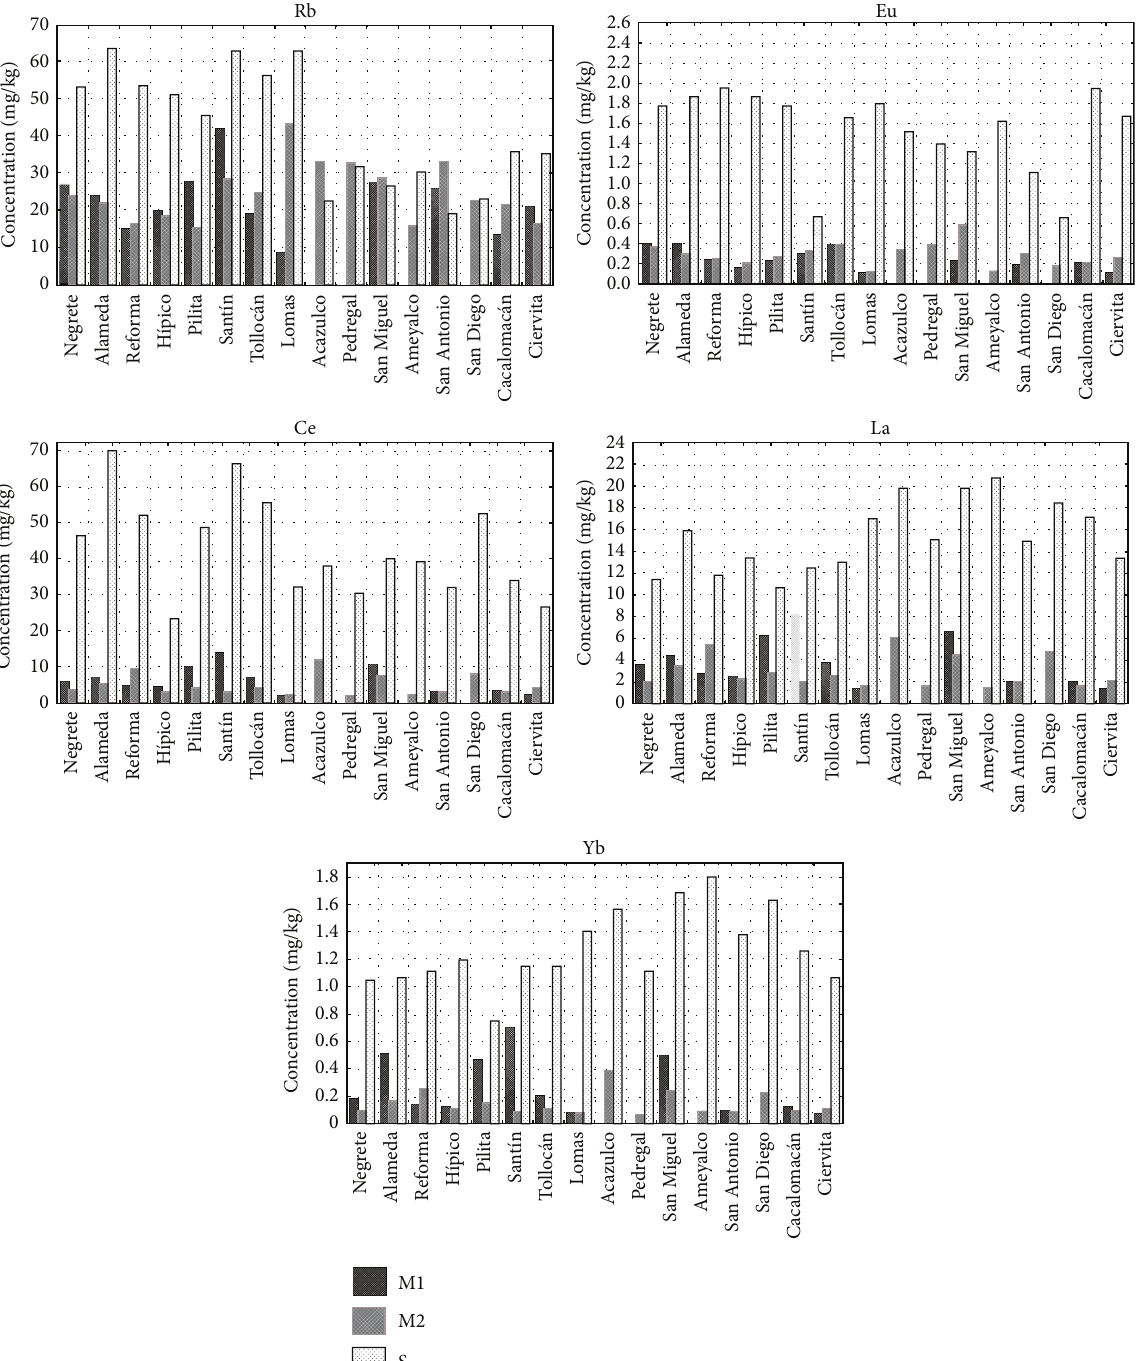
and Yb, whereas the sites located in Negrete (UR), San Diego (PA), and Ameyalco (TR) present the highest concentrations of Cr (Sant´ın (UR), San Antonio (PA), and Acazulco (TR)); of Hg (San Diego (PA), San Miguel (TR), and Alameda (UR)); of Se (San Diego (PA), Acazulco (TR), and Tolloc´an (UR)); of Co (Lomas (TR), Negrete (UR), and Acazulco